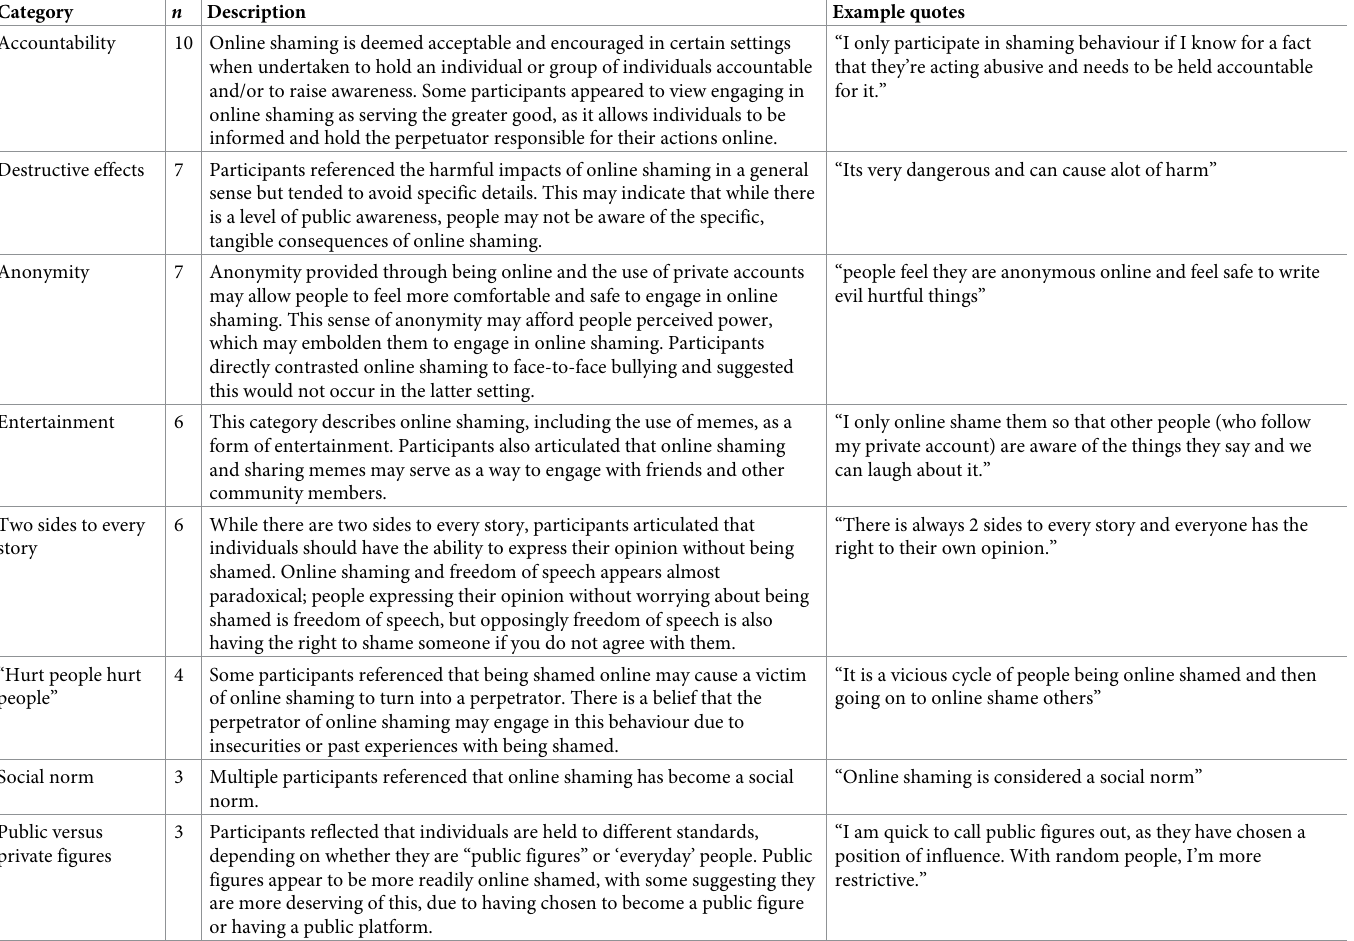
Table 4. Content analysis of what participants have to say about online shaming ( n =